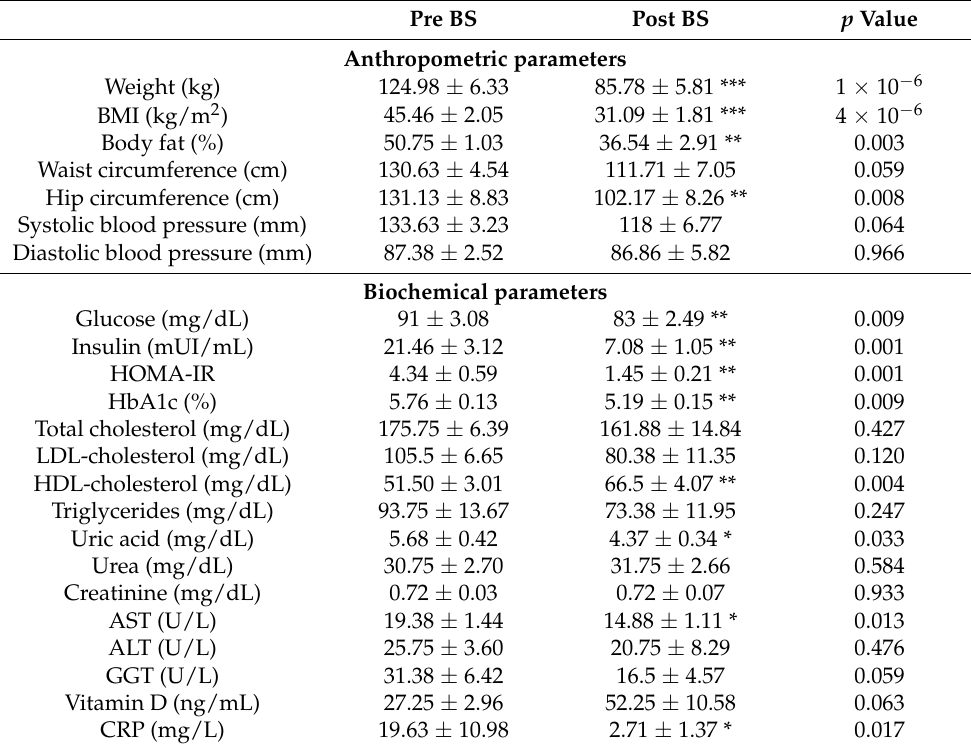
Table 1. Anthropometric and biochemical information before and after bariatric surgery of patients with severe